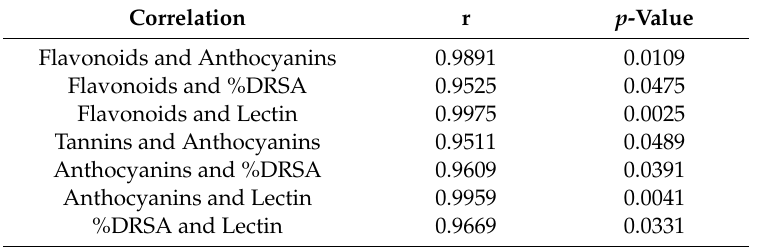
Table 4. Pearson’s correlation coe ffi cients of the bioactive compounds of the di ff erent Phaseolus